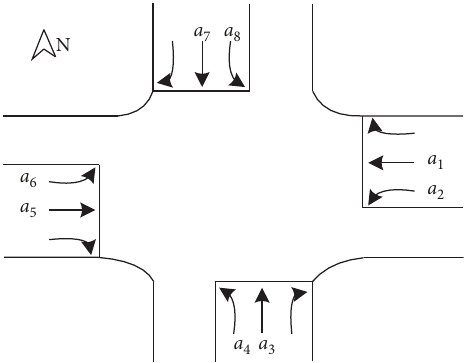
Figure 1: Main controlled trafc fow at a typical